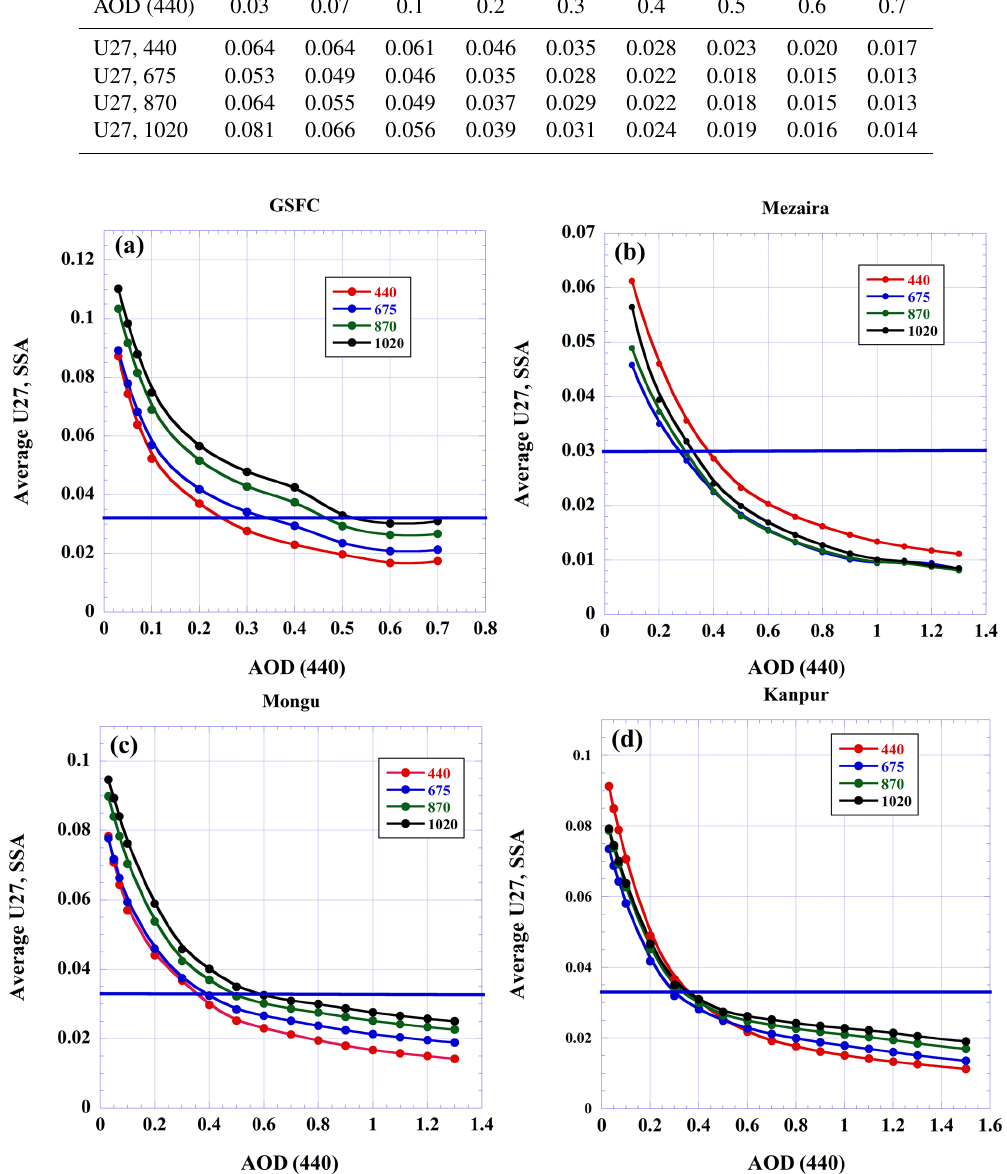
Figure 22. SSA uncertainties generated by averaging over AOD bins with subsequent interpolation to the regularly spaced AOD grid: (a) GSFC, (b) Mezaira, (c) Mongu, (d)